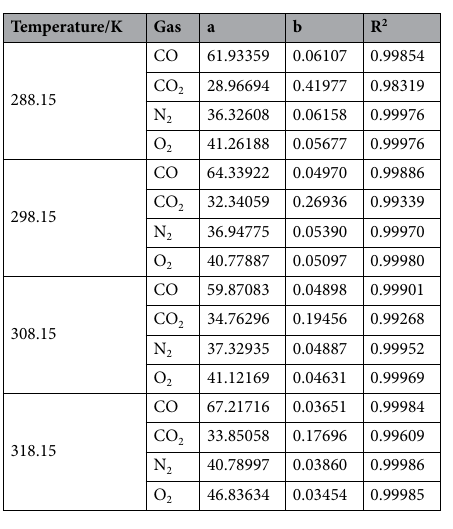
Table 2. Langmuir fitting parameters of single-component adsorption at different temperatures.